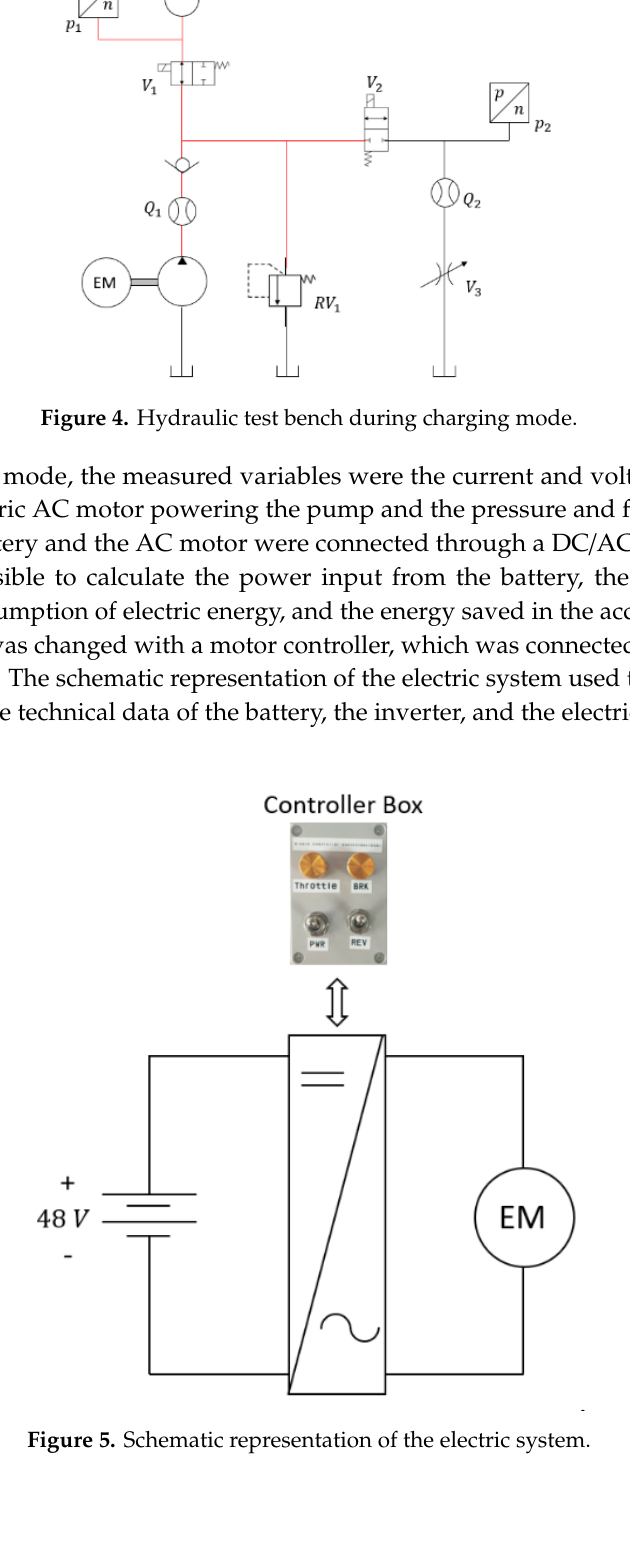
Figure 4. Hydraulic test bench during charging mode.